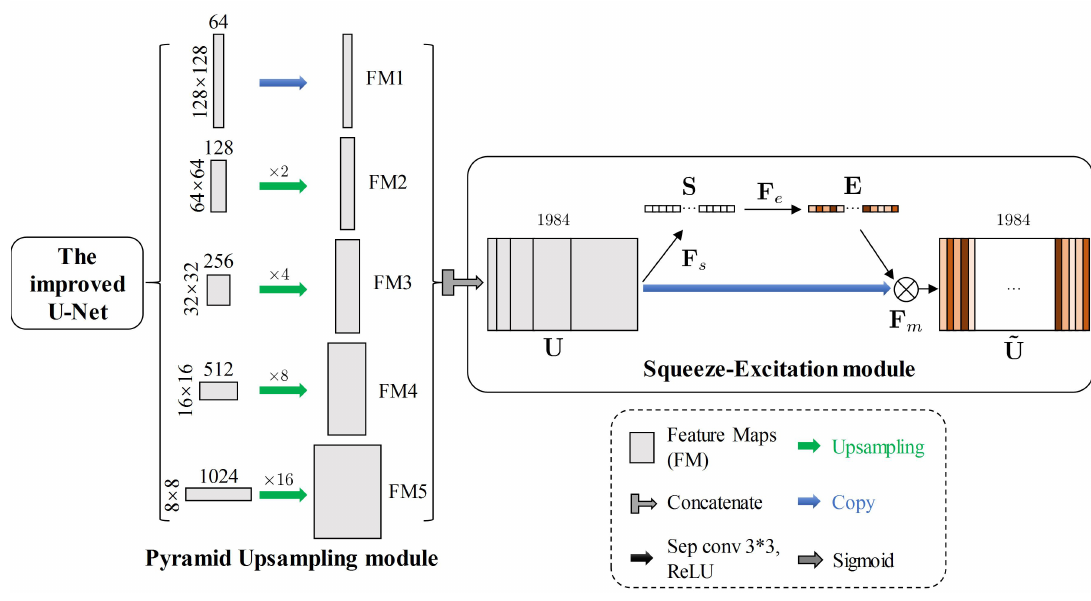
Figure 6. The PSE structure, including the pyramid upsampling module and the squeeze-excitation